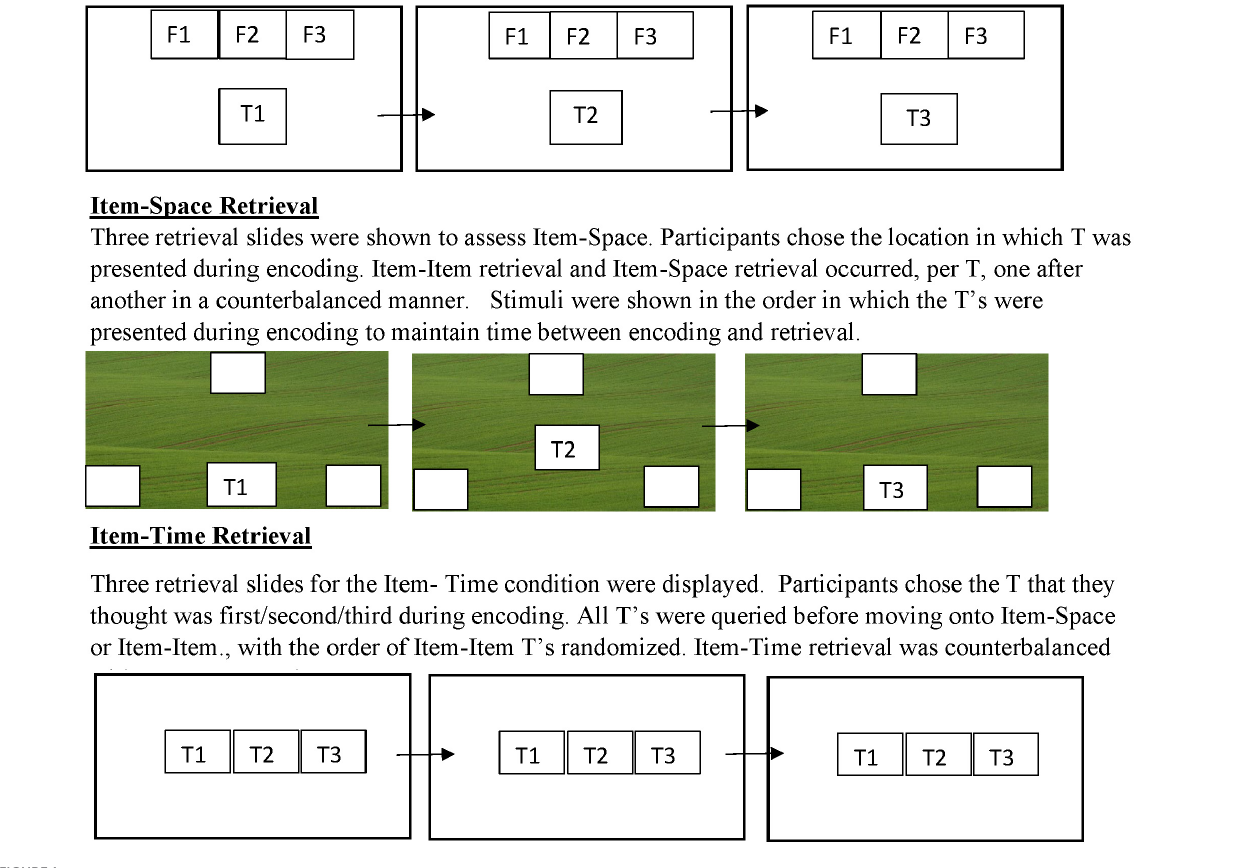
FIGURE1 Graphic depiction of the task order within an Emotional Block. Happy and Angry blocks were counterbalanced within the participants. T (Target) and F (Friend) identities were randomly chosen across blocks, such that there was never the same T or F displayed in the Angry and Happy conditions. The usage of 1-2-3 is for heuristic purposes only. The order and pairings of T’s and F’s was random with no repetition across emotional blocks. T and F pictures were chosen from the NIMH ChEFS picture bank (Egger et al.,